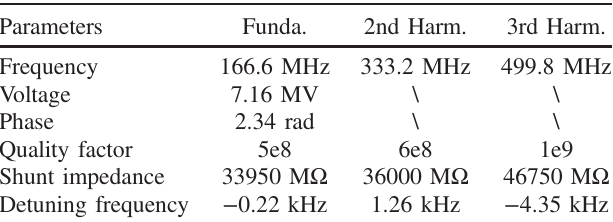
TABLE IV. Hardware parameters of the triple-frequency rf system using in simulation, the 2nd and 3rd harmonic cavities are passive, while the main cavities work on active. Funda.